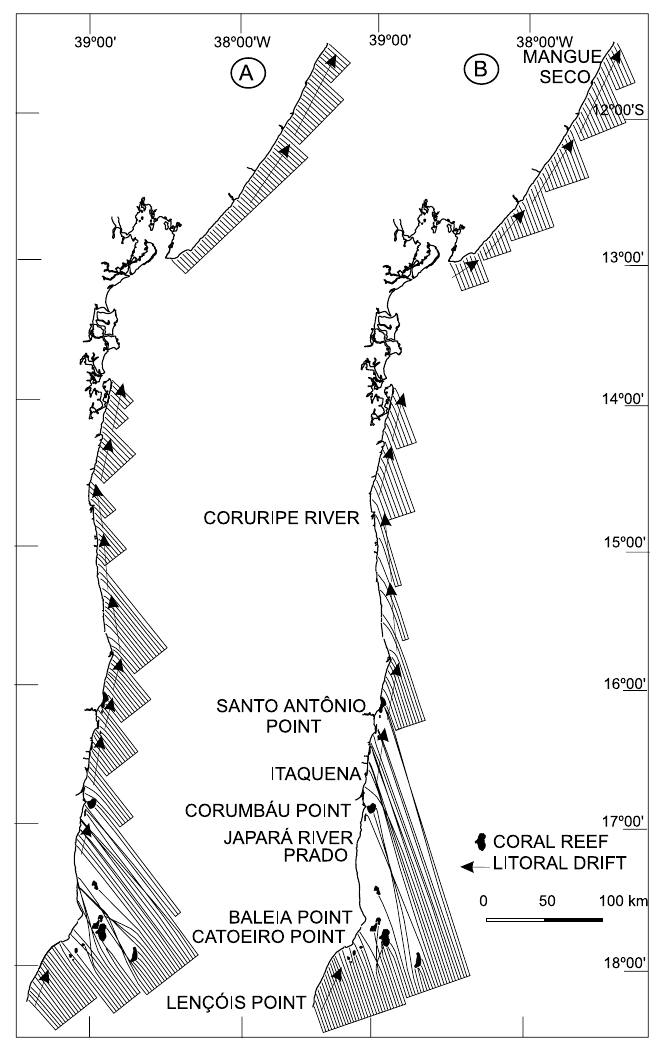
Fig. 3 – Refraction diagram for waves with a 6.5 sec period, arising from the SE (N135 ◦ ) (A) and SSE (N157.5 ◦ ) (B), referred to the coastal stretch of the State of